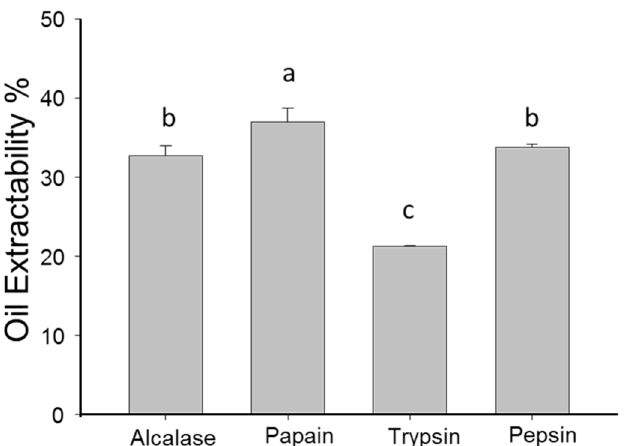
Figure 2. E ff ect of di ff erent commercial proteases used for EAAE on oil extractability. Means with Figure 2. Effect of different commercial proteases used for EAAE on oil extractability. Means with di ff erent superscript letters significantly di ff er ( p < 0.05). The hydrolysis conditions for alcalase was different superscript letters significantly differ ( p < 0.05). The hydrolysis conditions for alcalase was pH = 7.5 and 50 ◦ C, papain was pH = 6.0 and 30 ◦ C, pepsin was pH = 2.0 and 37 ◦ C, trypsin was pH = 7.5 and 50 °C, papain was pH = 6.0 and 30 °C, pepsin was pH = 2.0 and 37 °C, trypsin was pH = pH = 8.0 and 37 ◦ 8.0 and 37 °C.